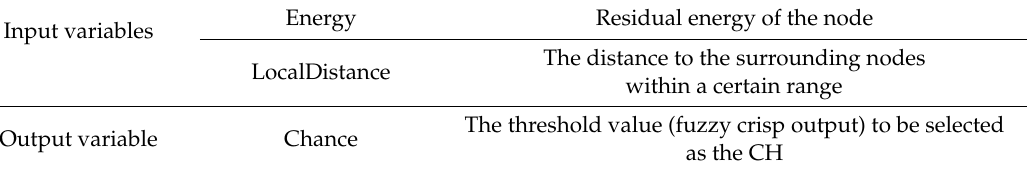
Figure 5. First FIS for cluster head (CH) selection.